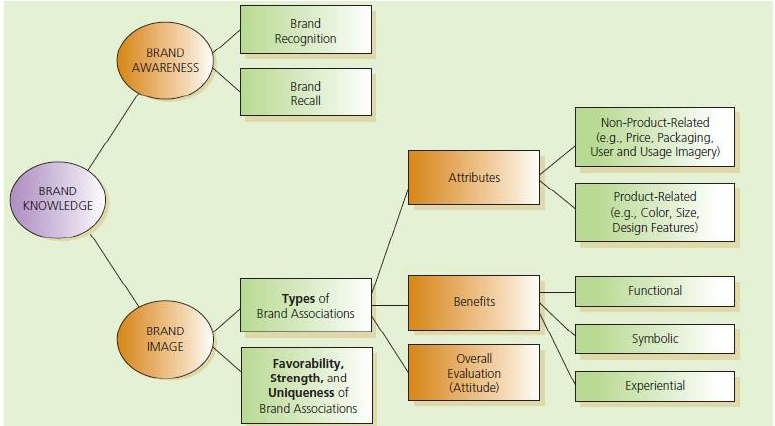
Figure 1: Brand knowledge model; Source: Shimp & Andrews